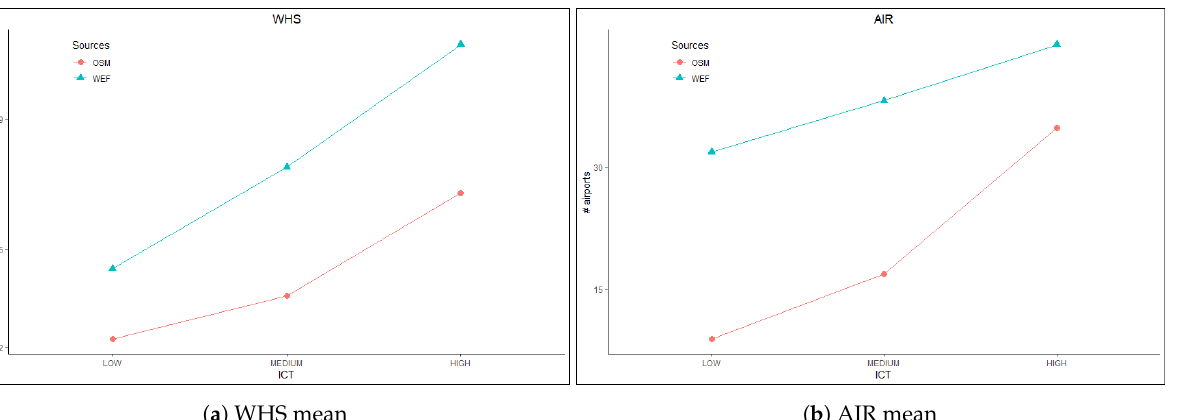
Figure 4. WHS and AIR variables’ means for different ICT